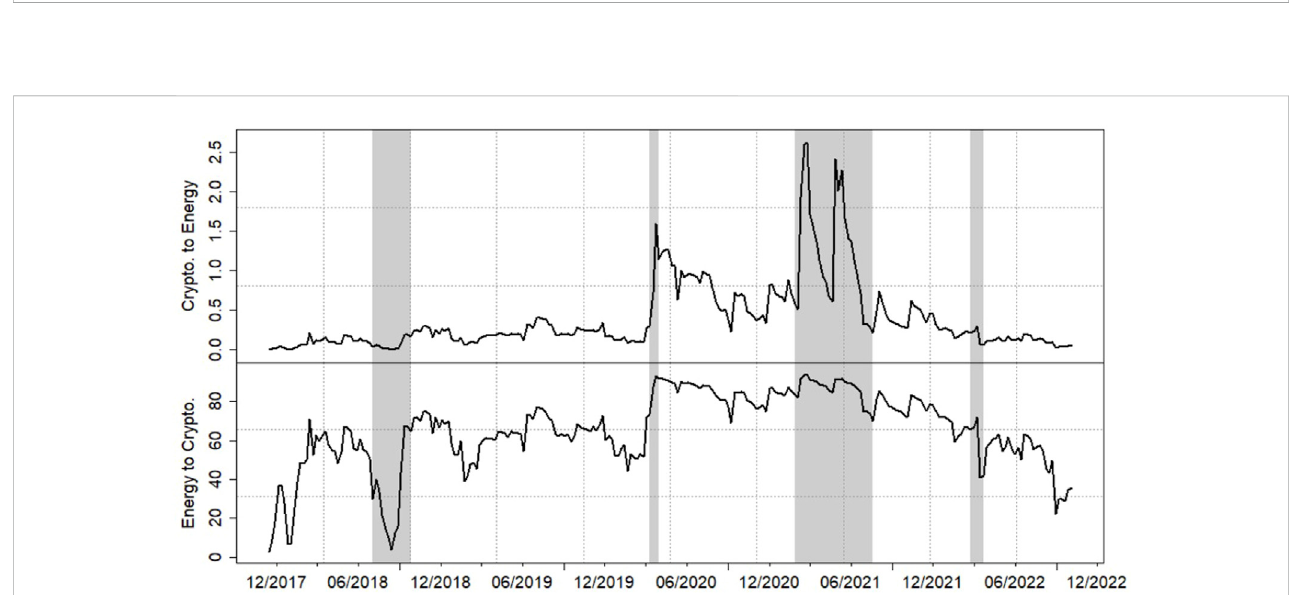
FIGURE 5 Directional volatility connectedness.Wehighlight fourpoints (using agray background). Inaddition to thethree pointsmentionedintheFigures 3, 4,the fi gure also highlights the period from January 26, 20201 to July 20, 2021. Two in fl uential occured in this period. The fi rst is theinaguration of theJoe Biden in late January 2021, and the second is a series of Elon Musk ’ s announcements on investing in